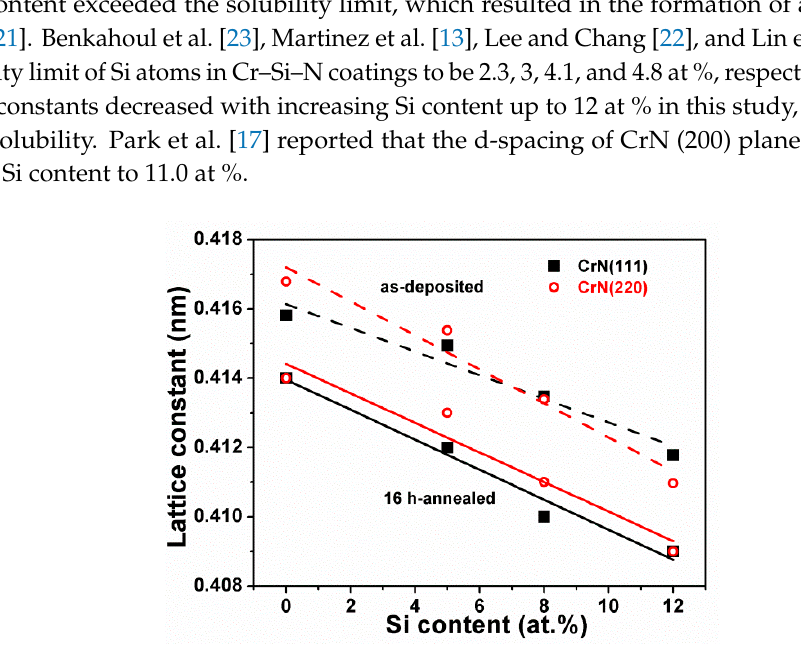
Figure 2. Lattice constants of the as-deposited and 16 h-annealed Cr–Si–N coatings determined from (111) and (220) reflections of the XRD patterns.